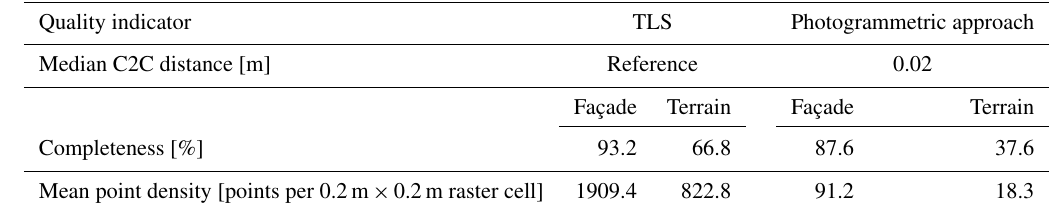
Table 2. Quality indicators of the photogrammetric point cloud registration in comparison to the TLS point cloud. Quality